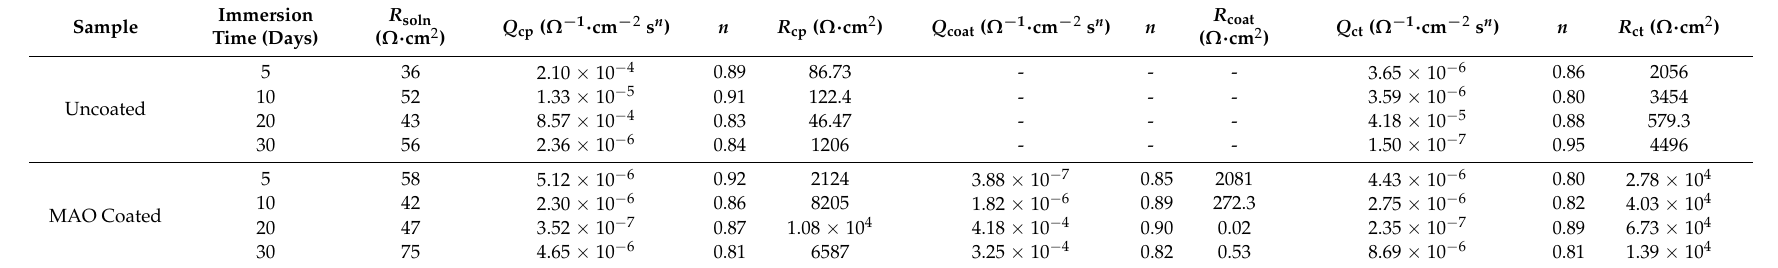
Table 3. Electrochemical parameters of the uncoated and coated samples after immersion in SBF for various amounts of time.